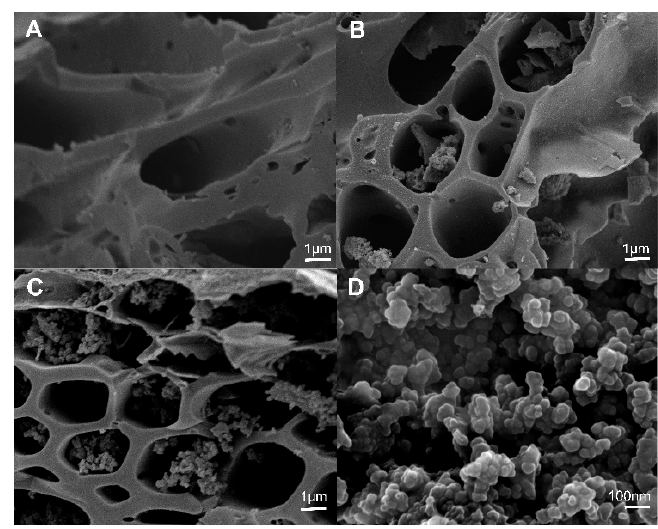
Figure 5. Scanning electron microscopy (SEM) of modified biochars: ( A ) Raw rice husk biochars; ( B ) raw biochar modified by the addition of 0.5 g cystamine dihydrochloride and 25 mL glutaraldehyde (2%); ( C ) raw biochar modified by the addition of 0.75 g cystamine dihydrochloride and 25 mL glutaraldehyde (2%); ( D ) modified polymer on the surface of biochars.